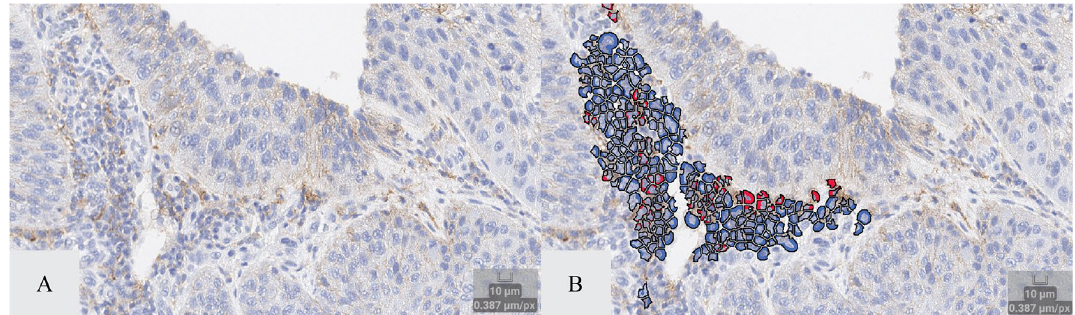
Figure 7. Lymphocyte identification and PD-L1 positivity IA solution. Panel ( A ) shows a field of view of stromal lymphocytes. Panel ( B ) shows the same field of view with labeled lymphocytes (as identified by the recognition algorithm) with and without PD-L1 staining (red = PD-L1 positive; blue = PD-L1